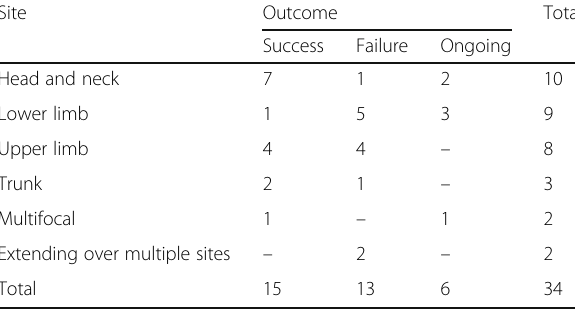
Table 2 Distribution of VMs by site and sclerotherapy treatment outcome